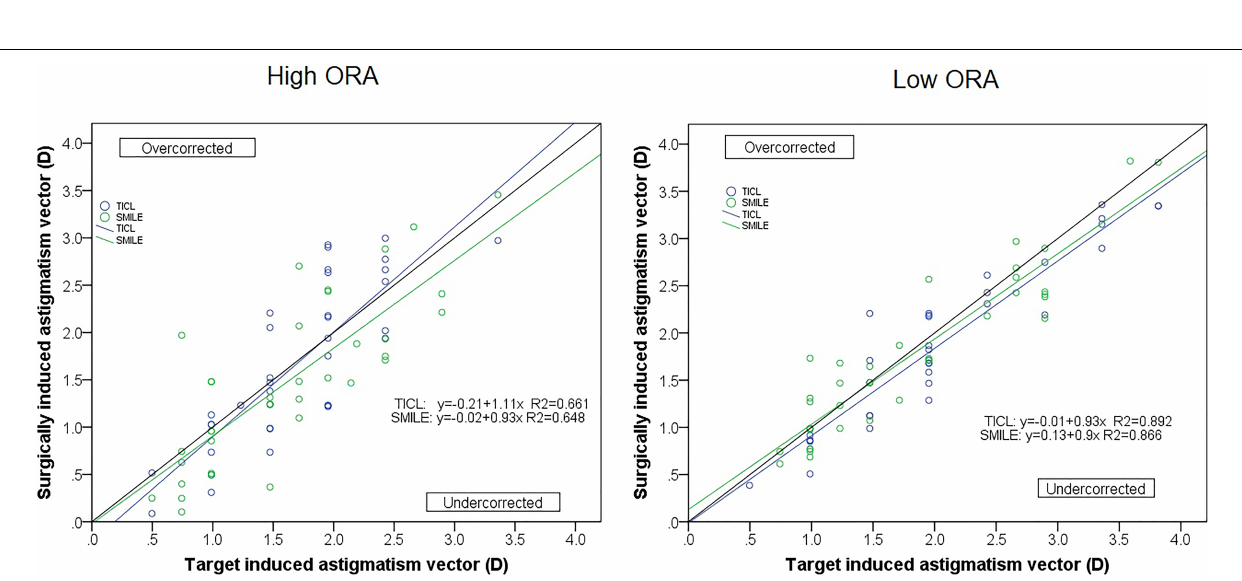
Frontiers in Medicine |